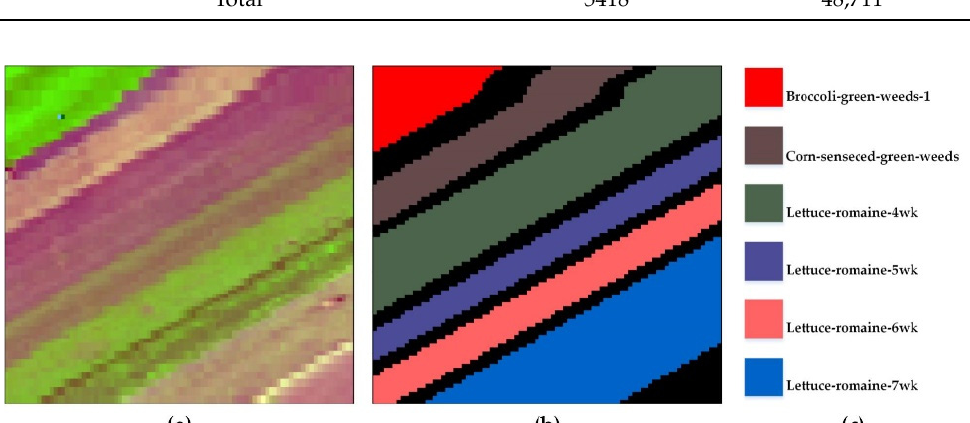
Figure 6. The SAC dataset. ( a ) False-color image, ( b ) Ground-truth image, ( c ) Labels.